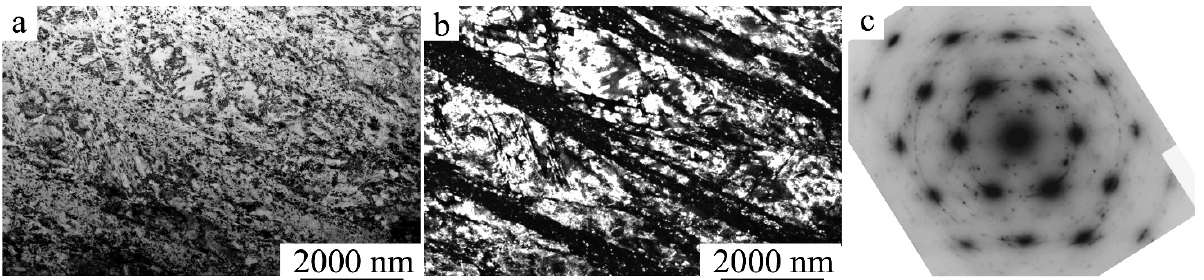
Figure 8. ( a ) Bright- and ( b ) dark-field TEM images of the microstructure, and ( c ) the corresponding SAED pattern (z.a. of type <110> B 19’ , SD 0.3 µm), of the CG Ti 49.4 Ni 50.6 alloy after straining (to 20%) ing SAED pattern (z.a. of type <110> B 19’ , SD 0.3 µ m), of the CG Ti 49.4 Ni 50.6 alloy after straining [73]. (to 20%)